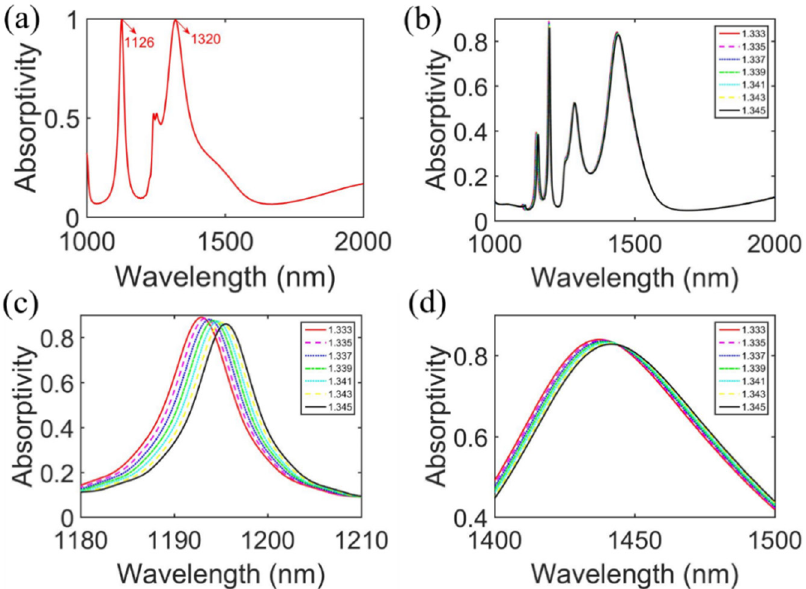
Figure 8. The simulated absorptivity of the optimized MIMIM structure in ( a ) air and ( b ) solutions of different refractive indices. ( c,d ) Refractive index ‐ dependent absorptions of the antisymmetric mode and ENZ mode.